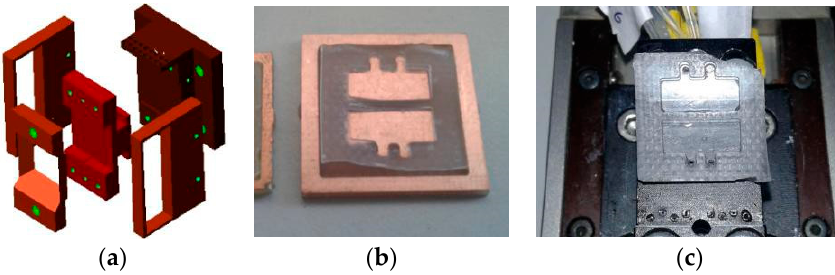
Figure 2. ( a ) Aluminium flow cell; ( b ) casting mold for the PDMS, using printed circuit board (PCB) technology; ( c ) photograph of the fabricated PDMS fluidic gasket, showing the two chambers.